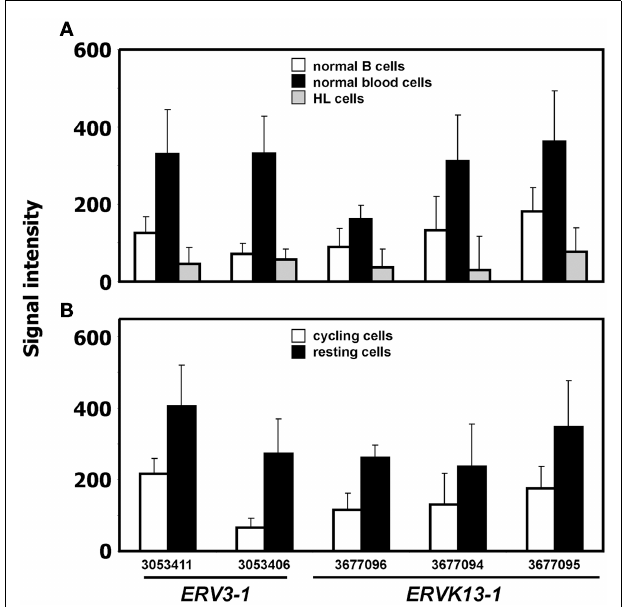
FIGURE 2 | ERV with significant difference between HL and normal blood samples . (A) Presented are signal intensities (means and standard deviations) of the indicated probe sets ( ERV3-1 : probe sets 303411 and 3053406; ERVK13-1 : probe sets 3677096, 3677094, and 3677095) in normal blood cells [GEO data set GSE18838 (40)], normal B cells [GEO data sets GSE14352 and GSE5188 (42, 43)], and HL cell lines. (B) Signal intensities of the same probe sets in P493-6 cells after treatment with tetracycline (resting cells) or medium without tetracycline [cycling cells; raw data from GEO data set GSE32219 (41)].